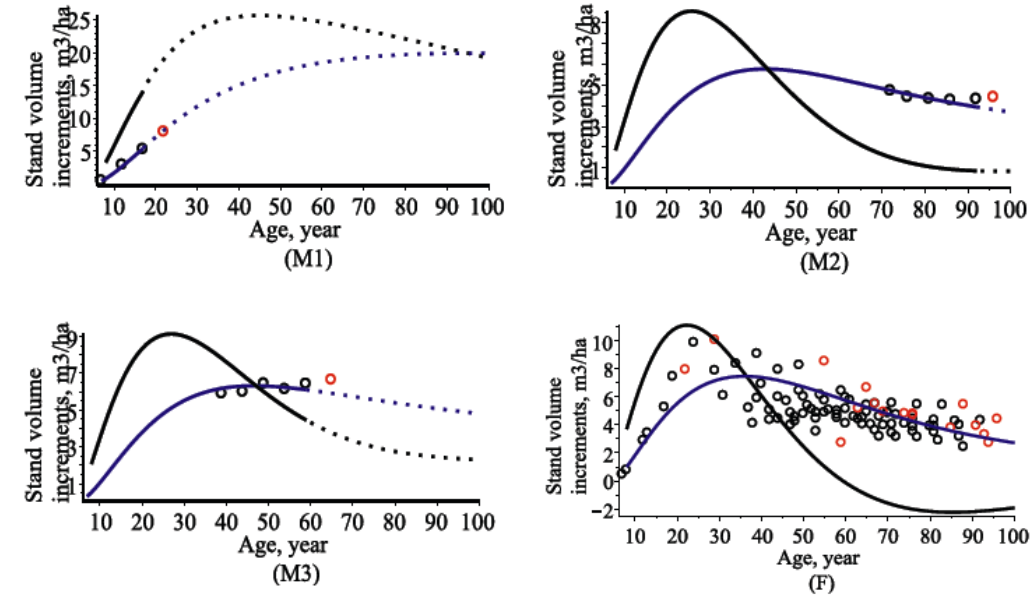
Figure 9. Evolution of current and mean annual stand volume increments over age. ( M1 ) mixed effects scenario for the first stand; ( M2 ) mixed effects scenario for the second stand; ( M3 ) mixed effects scenario for the third stand; ( F ) fixed effects scenario for all stands; black solid line-CAI V prediction curve; black dot line–CAI V forecast curve; blue solid line-MAI V prediction curve; blue dot line–MAI V forecast curve; black circles–estimation dataset, red circles–validation (forecast) dataset.